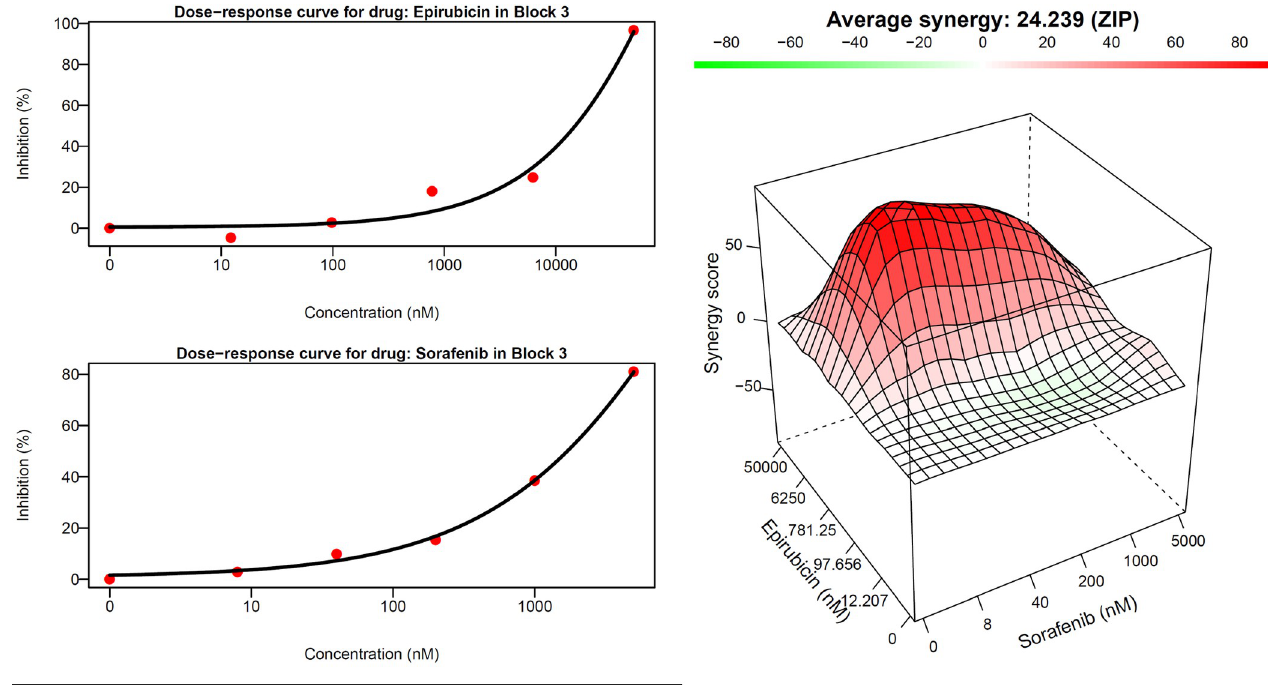
Fig 10. The synergistic drug combinations of Epirubicin and